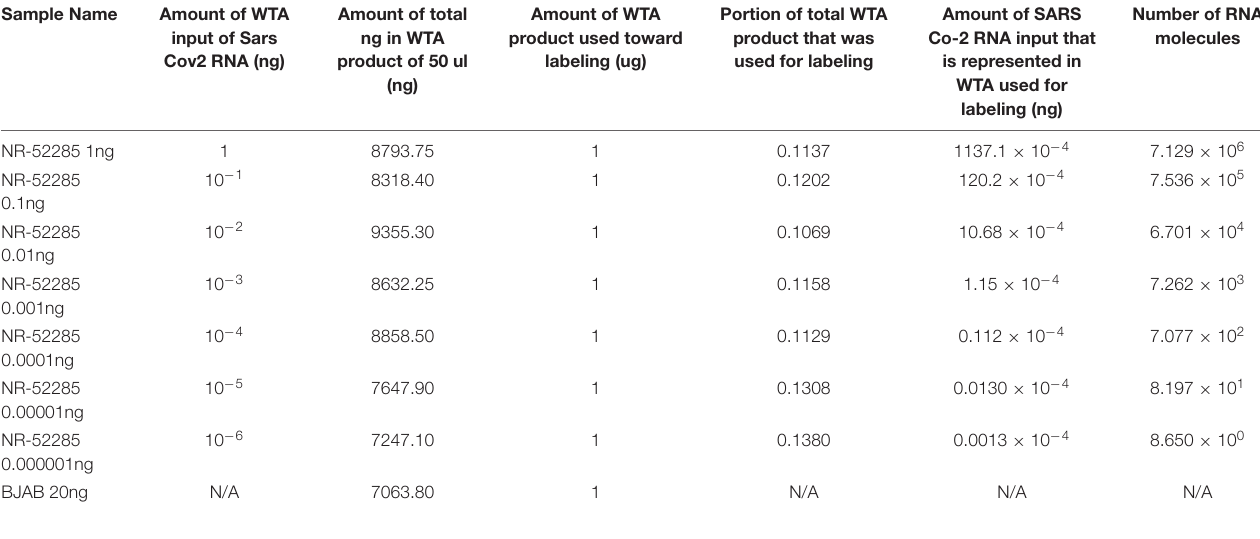
TABLE 1 | Calculations of different concentration of standard RNA